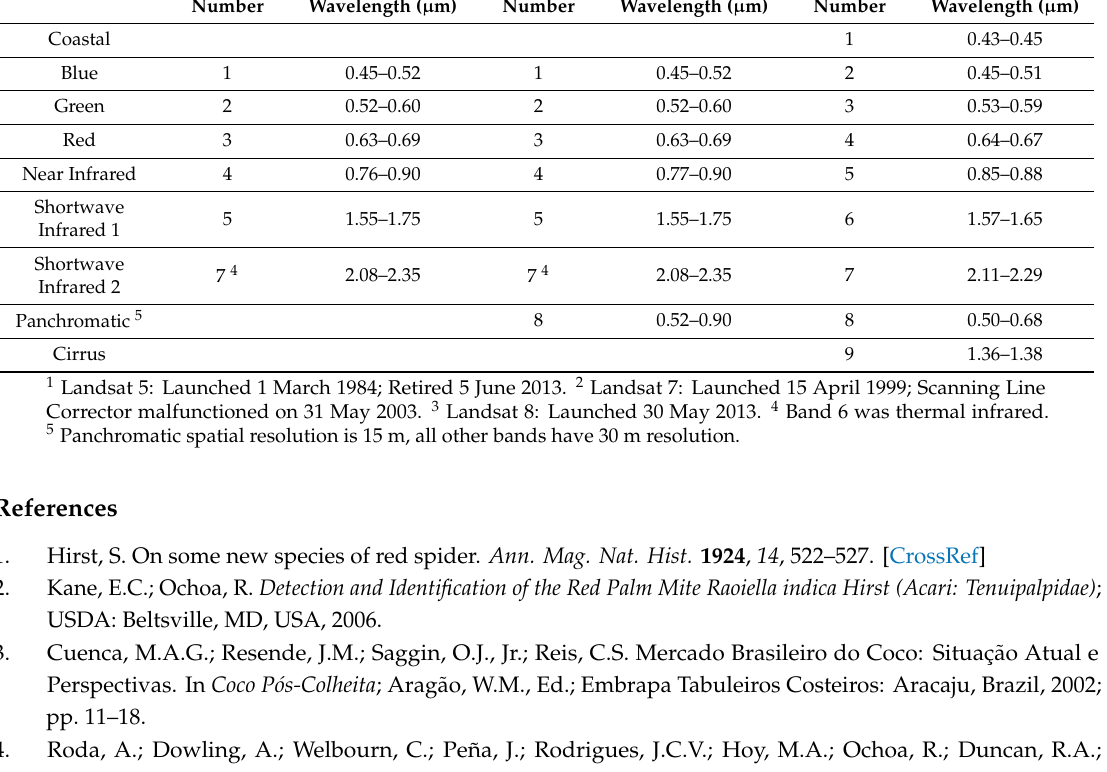
Table A2. Sensor wavebands for Landsat 5 Thematic Mapper (L5-TM), Landsat 7 Enhanced Thematic Mapper Plus (L7-ETM + ), and Landsat 8 Operational Land Imager (L8-OLI).